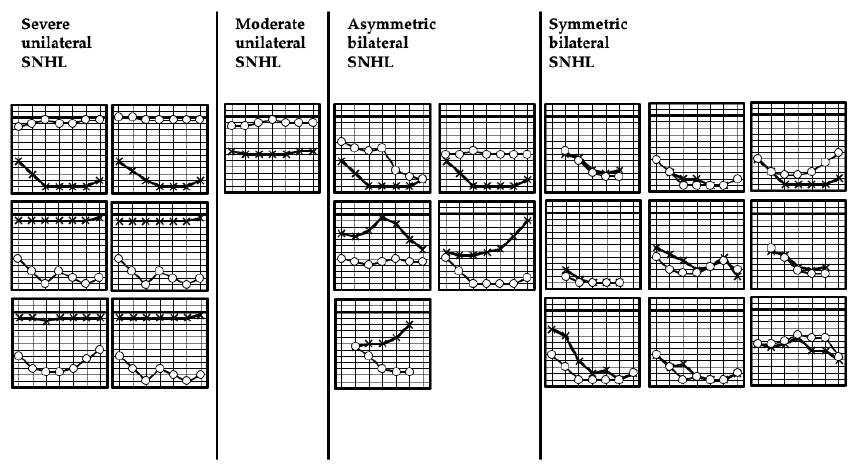
Figure 3. Audiograms of 21 patients who were diagnosed with hearing loss due to cCMV infection. SNHL, sensorineural hearing loss. P, U, and R indicate the NHS result of each case. P: bilateral pass, U: Unilateral pass and unilateral refer, R: bilateral refer.